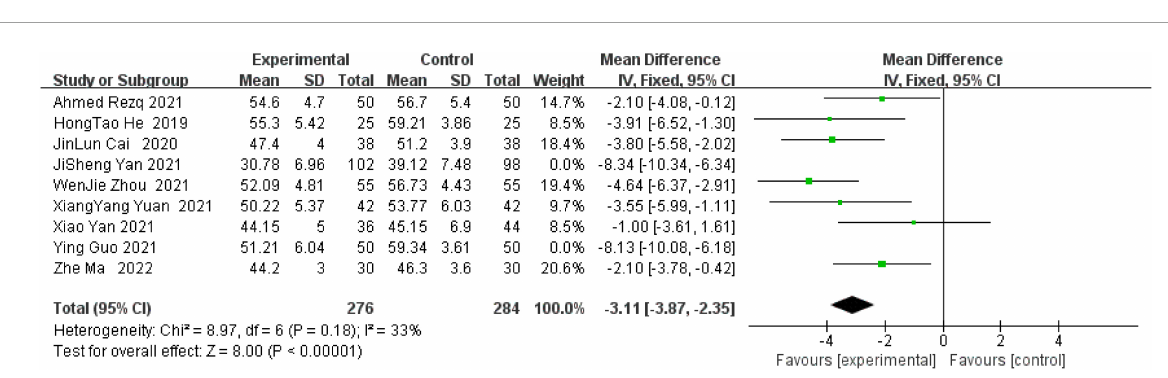
FIGURE6 Left ventricular end-diastolic diameter (LVEDD) within 6 months after surgery.